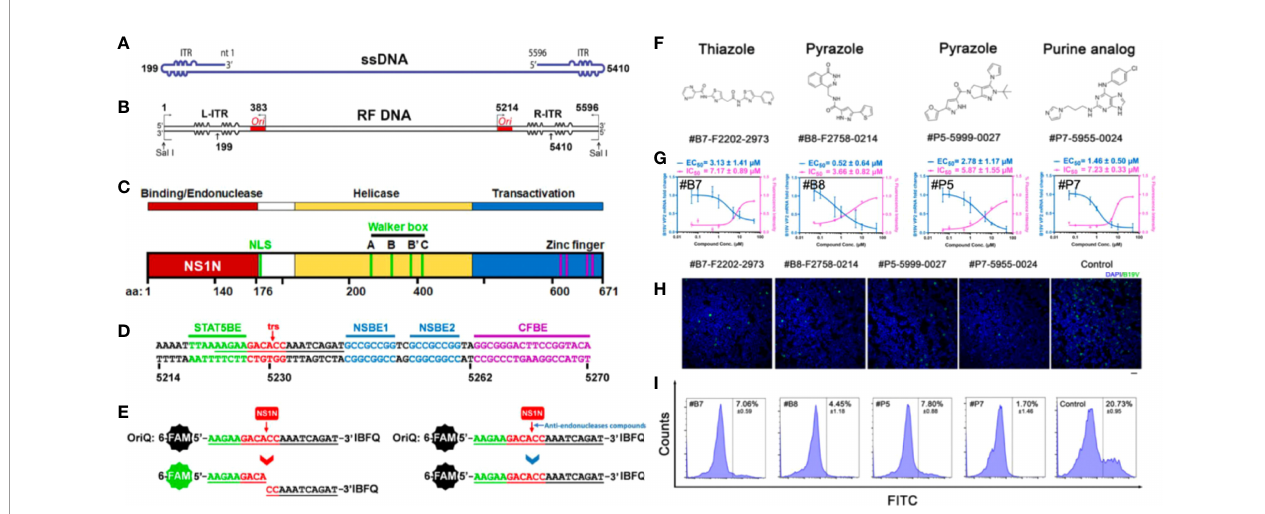
FIGURE 2 | Fluorophore-based in vitro nicking assay for high throughput screening of anti-B19V compounds. (A) B19V ssDNA genome. (B) B19V RF DNA. (C) A diagram of B19V NS1 protein. (D) Minimal replication origin (Ori) of B19V. (E) Diagram of fl uorophore-based in vitro nicking assay for high throughput screening of anti-B19V antivirals. (F – I) Four selected compounds (#B7 (F2202-2973), #B8 (F2758-0214), #P5 (F5999-0027) and #P7 (F5955-0024)) for inhibition assay in CD36 + EPCs. (F) Chemical structures. (G) Measured EC 50 and IC 50 . (H) Immuno fl uorescent assay (green, anti-B19V capsid antibody). (I) Flow cytometry of EPCs stained with a mouse anti-B19V capsid monoclonal antibody and a FITC conjugated secondary antibody. Reproduced with permission (Ning et al., 2022). Copyright © 2022 American Society for